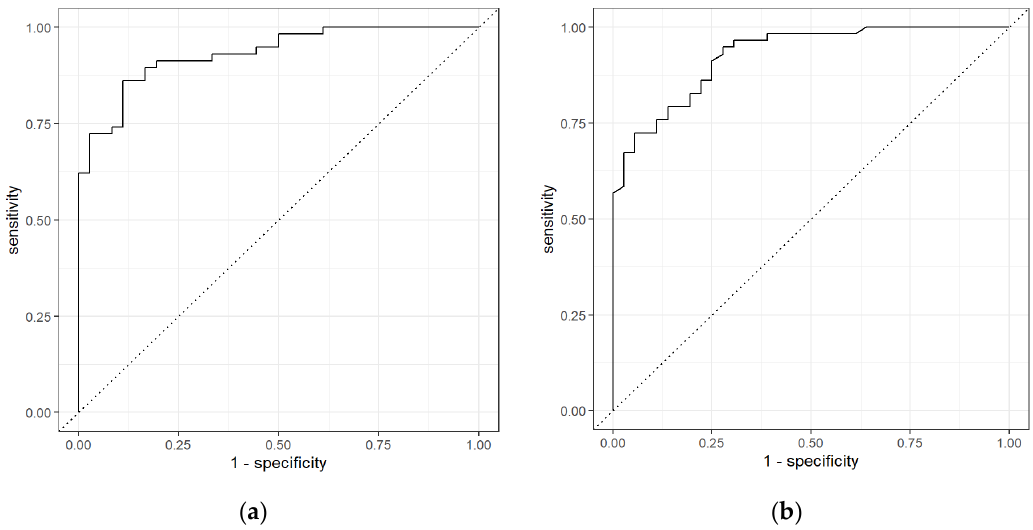
Figure 7. ROC for CRC vs. non-Cancerous using ( a ) Neural Network and ( b ) Random Forest classifiers for GC-TOF-MS.